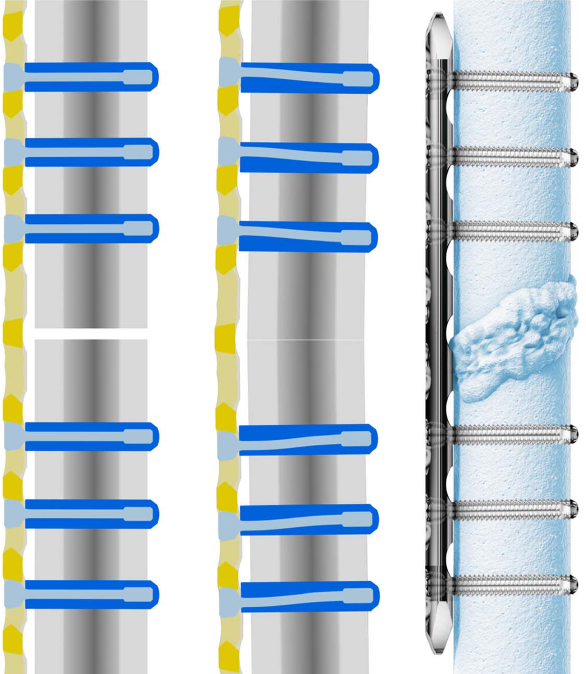
Figure 2. Osteosynthesis with DLS without and with axial load and circumferential callus formation.